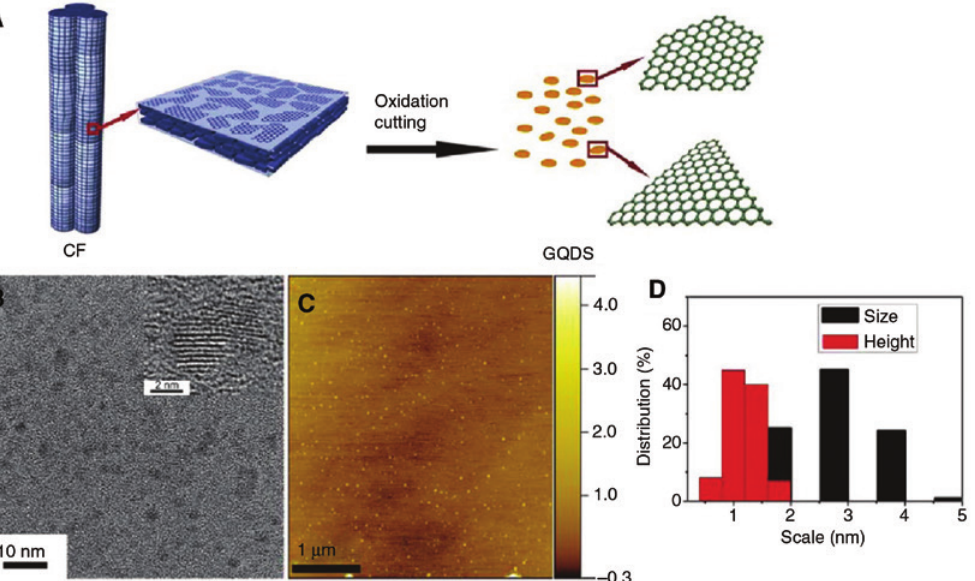
Figure 3: Illustration of the preparation process of GQDs by oxidation cutting showing both their morphology and size distribution. (A) Rep- resentation scheme of oxidation cutting of CF into GQDs. (B) TEM images of GQDs (synthesized reaction temperature at 120 ° C); inset of (B) is the HRTEM of GQDs. (C) AFM image of GQDs. (D) Size and height distribution of GQDs (reprinted/reproduced with the permission of Ref. [31], copyright 2012, American Chemical